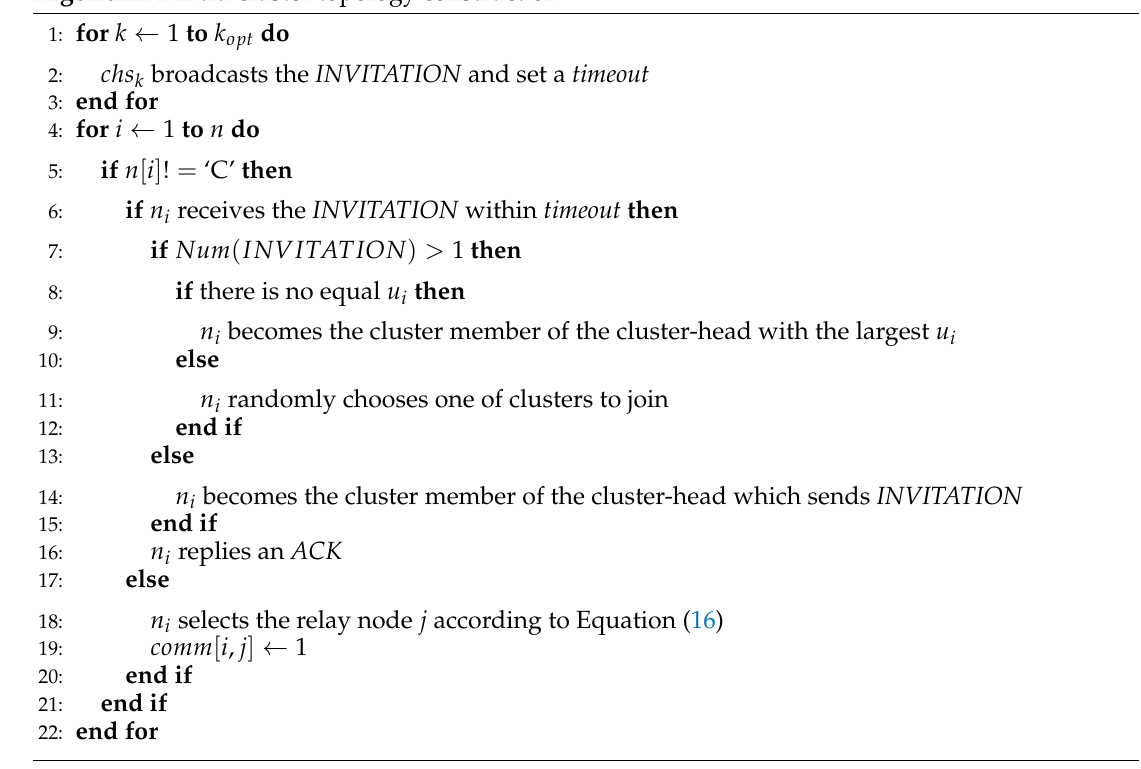
Algorithm 2 Intra-cluster topology